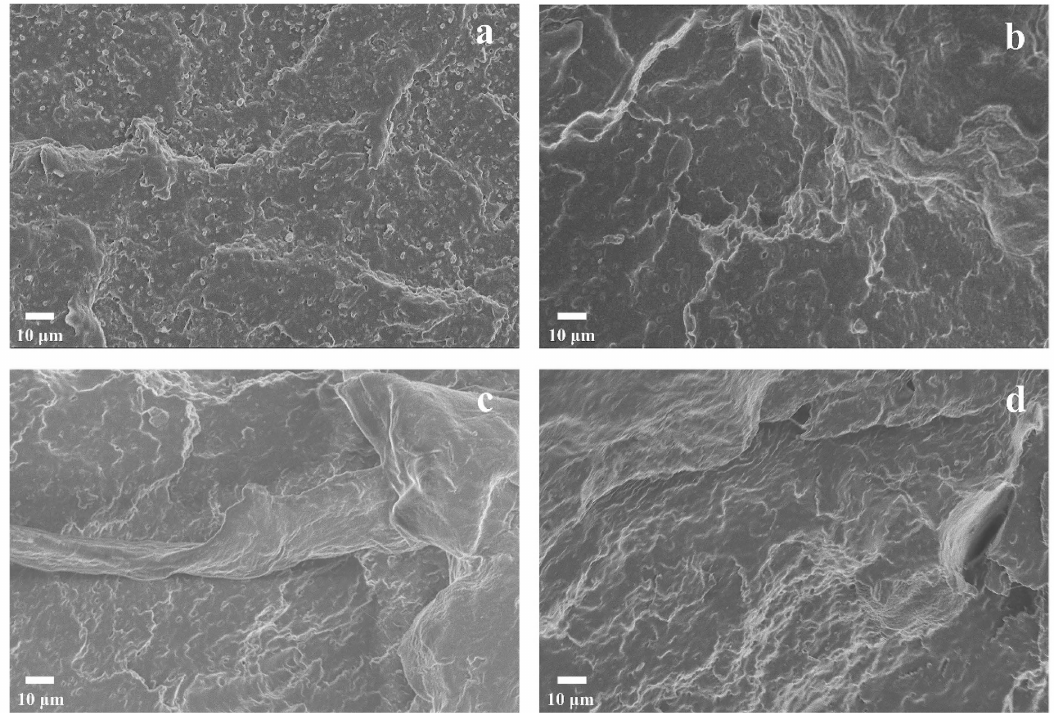
Figure 9. SEM micrographs of impact-fractured surfaces of PBST/PLA blends with various amounts of PSMA: ( a ) PB/PL, ( b ) PB/PL/PS1, ( c ) PB/PL/PS2, and ( d ) PB/PL/PS3